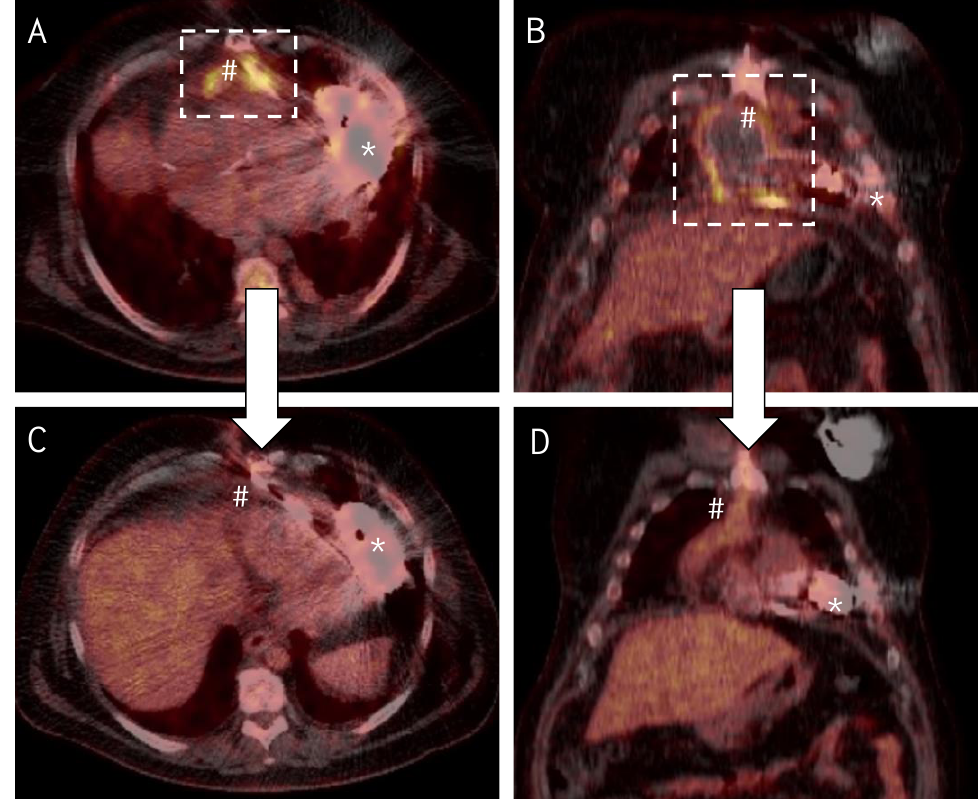
Figure 1. PET-CT scan before ( A , B ) and after ( C , D ) complex wound treatment. # Outflow graft of the LVAD-System; * Pump housing of the LVAD (HeartMate 3, Abbott, USA). The dashed rectangle shows contrast enhancement involving the outflow graft as a correlate for device infection.